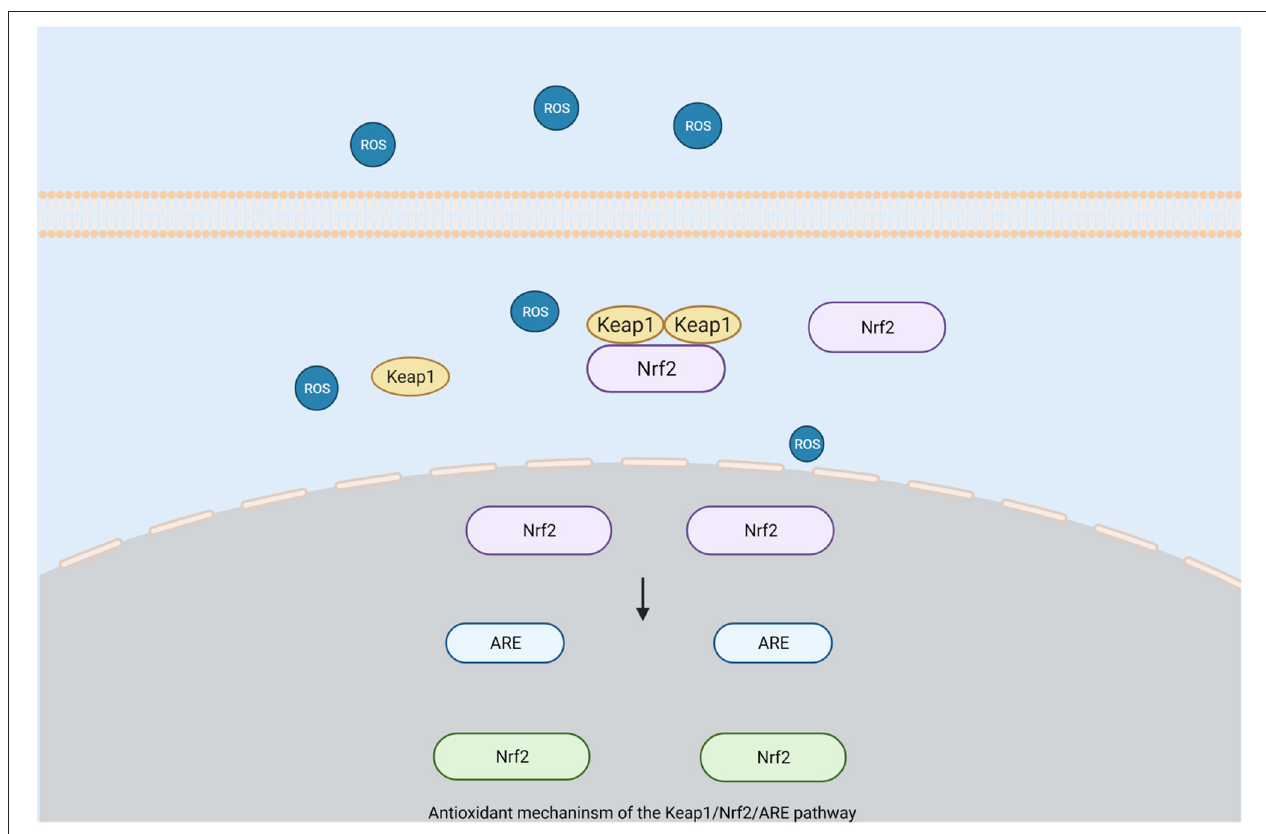
FIGURE 2 | Antioxidant mechanism of the Keap1/Nrf2/ARE pathway. When Nrf2 is exposed to reactive oxygen species, it will dissociate from Keap1 and translocate to the nucleus, while activating antioxidant response elements (ARE) that mediate cell survival to drive the expression of Nrf2 target genes for protective purposes. (Created with